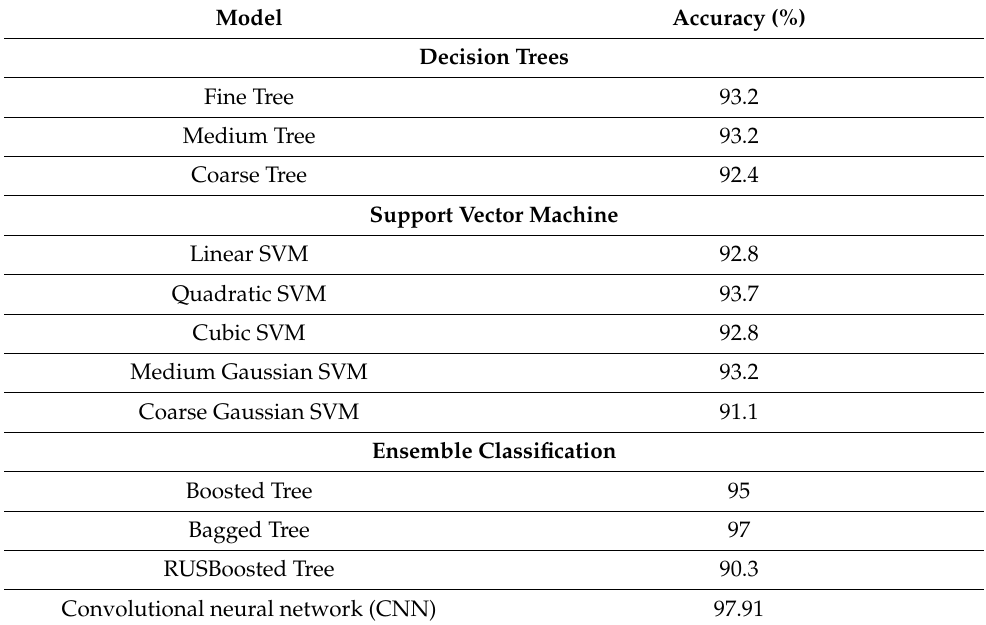
Table 4. Accuracy of various algorithms used in this study for the classification of gravel and non-gravel